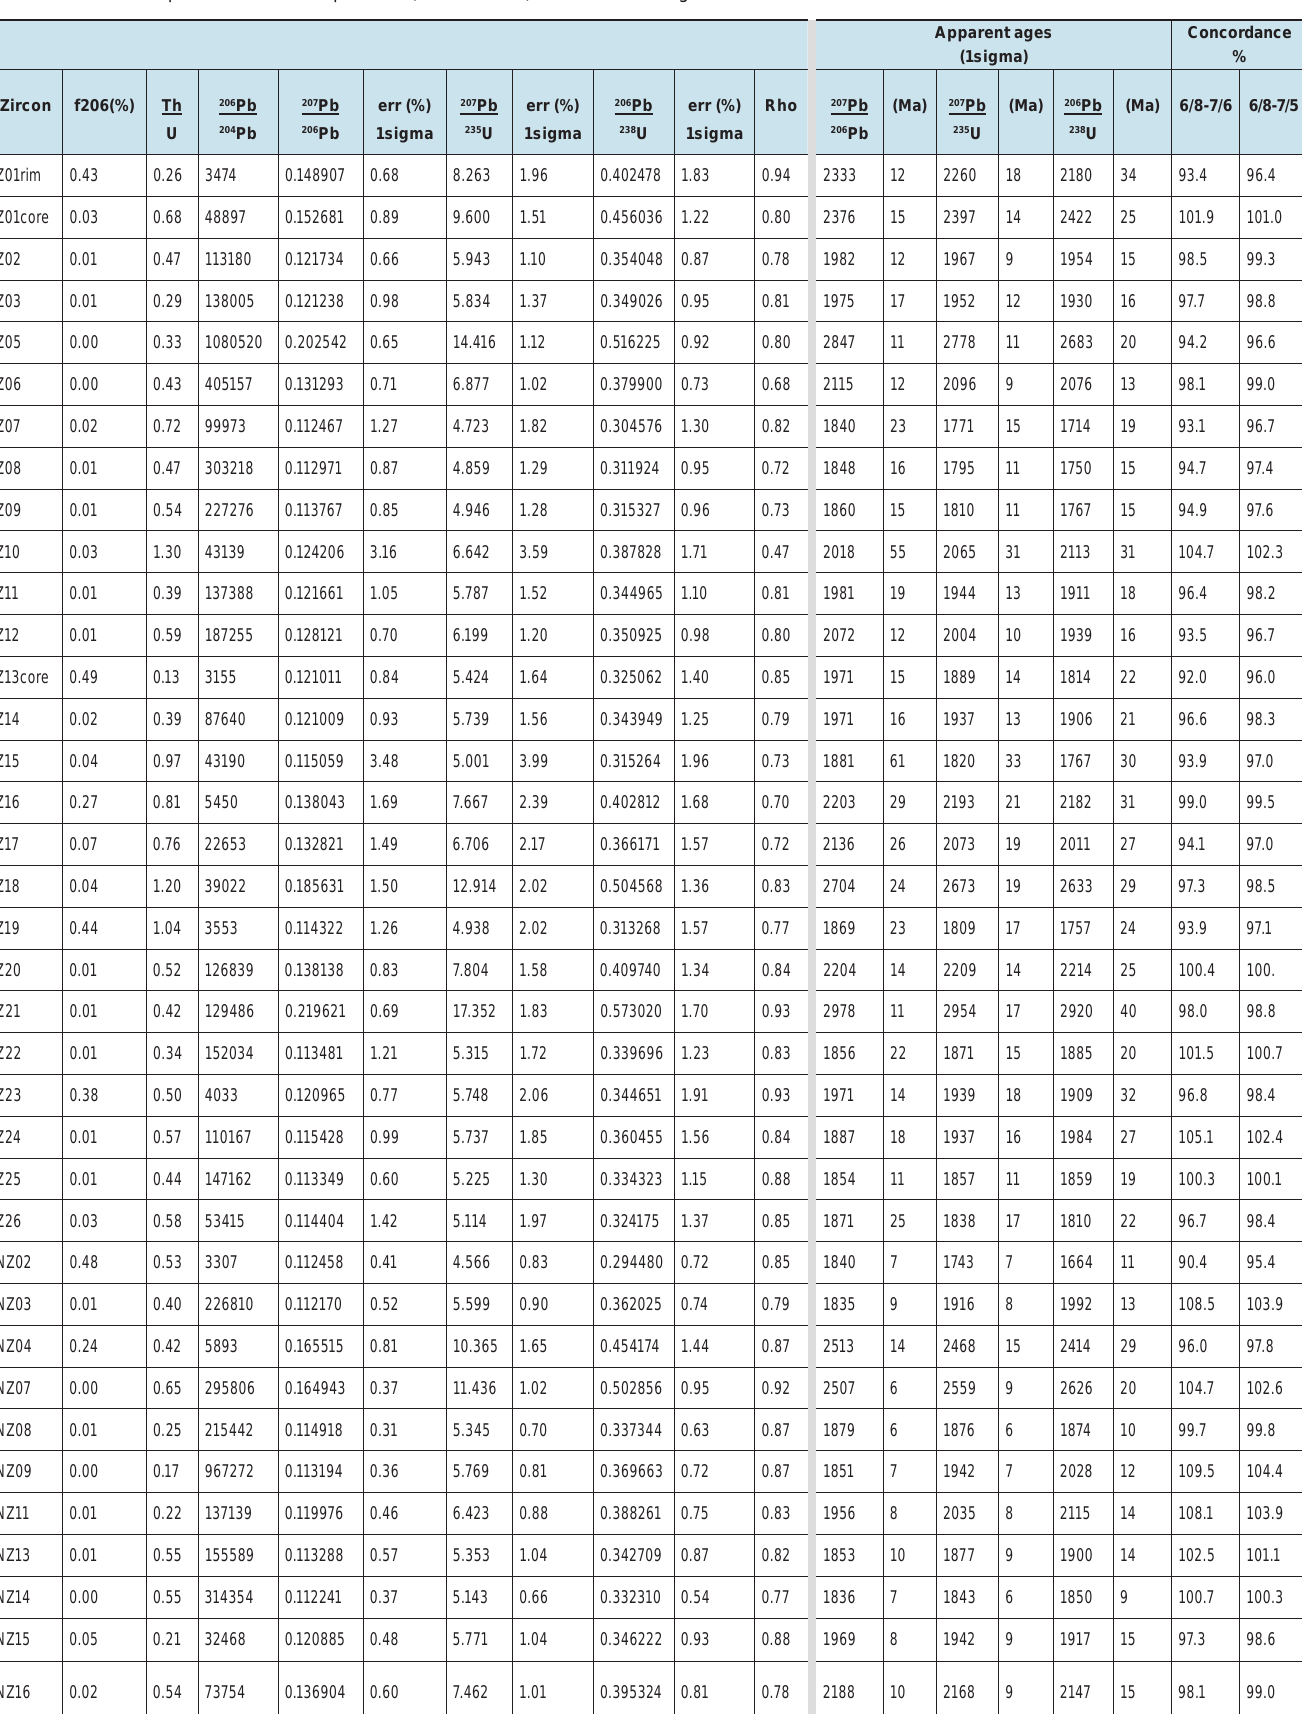
Table 2 - U-Pb isotopic results for sample CE7 (lithic arenite) of the Novo Progresso Formation